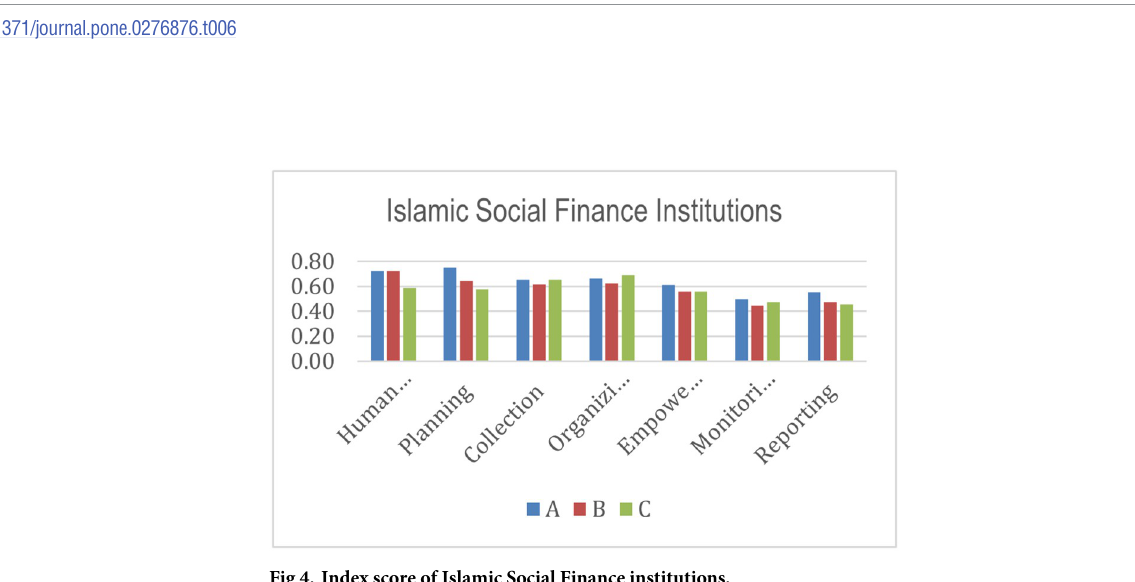
Index Score of Index Score of Indekx Score of Each Aspects Each Aspects Each Each Factors Stakeholders